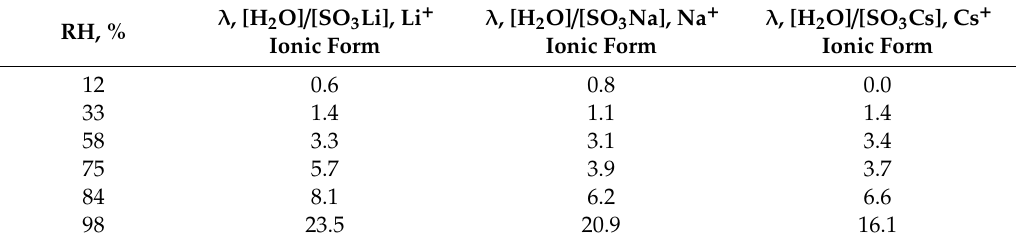
Table 1. Water uptake λ at di ff erent relative humidity RH for Li + , Na + , and Cs + ionic forms of MSC membrane. λ , [H 2 O] / [SO 3 Li], Li + λ , [H 2 O] / [SO 3 Na], Na + λ , [H 2 O] / [SO 3 Cs], Cs RH, % Ionic Form Ionic Form